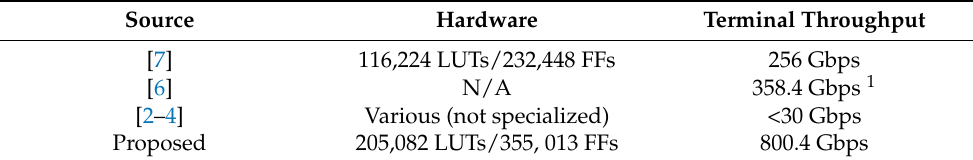
Table 3. A comparison of terminal throughput (with no memory updating) between the differ- ent